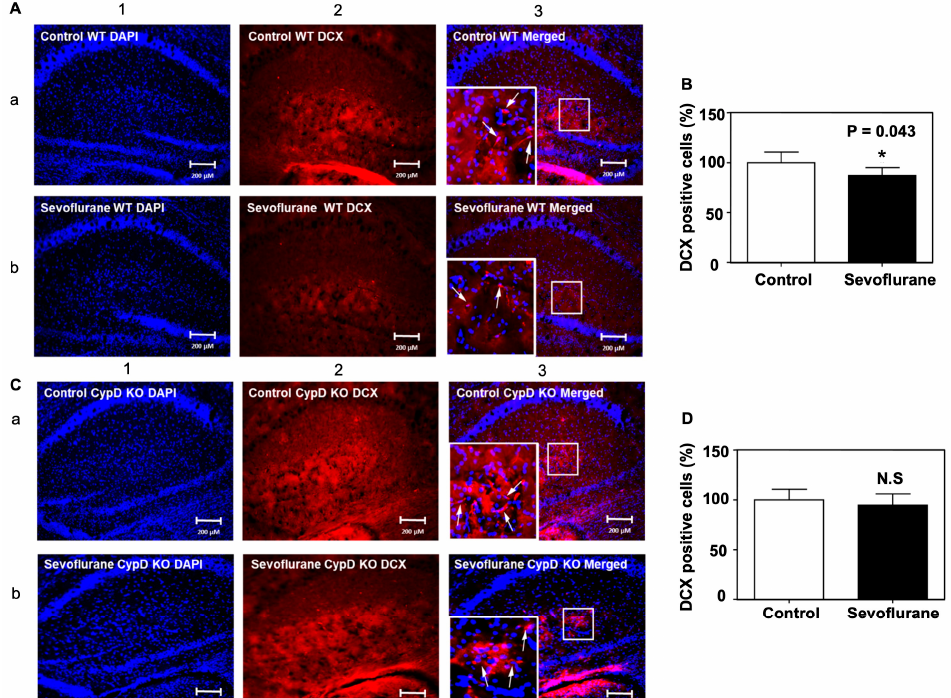
Figure 6. CypD KO mitigates the sevoflurane-induced decrease of DCX-positive cells in the hippocampus of mice. ( A ) Representative images of immunofluorescent staining DCX in the hippocampus of WT mice. Column 1 is the DAPI (blue) nuclear staining, column 2 is the DCX (red) staining, and column 3 is the merged staining image. Sevoflurane (row b) decreases the number of DCX-positive cells compared to the control condition (row a) in the hippocampus of WT mice. ( B ) Quantification of the image shows that sevoflurane (black bar) significantly decreases the number of DCX-positive cells compared to the control condition (white bar) (* p = 0.043). ( C ) Representative images of im- munofluorescent staining DCX in the hippocampus of CypD KO mice. ( D ) Quantification of the image shows that the sevoflurane anesthesia (black bar) does not change the number of DCX-positive cells in the hippocampus of CypD KO young mice compared to the control condition (white bar). N = 5–6 in each group. Student’s t -test was used to analyze the data. The arrows indicate the DCX positive cells in hippocampus. The Box indicates the zoom in image area in staining. N.S: non-significant